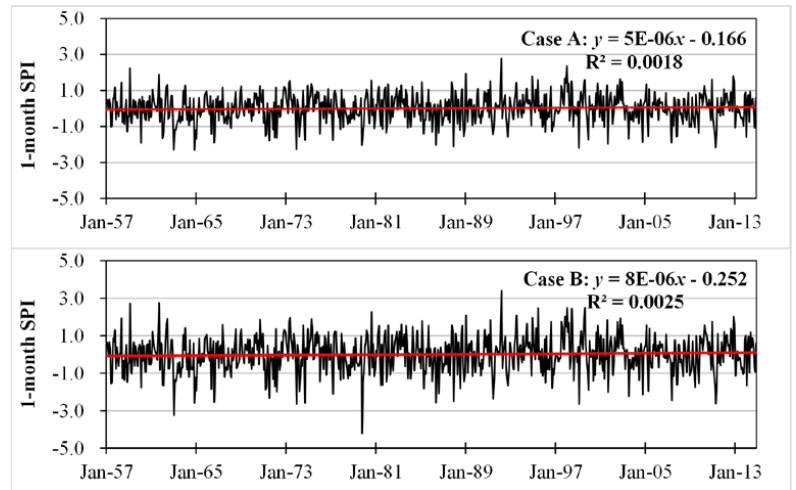
Figure 3. SPI time series obtained from the SPI-mean scheme (Case A) and from the precipitation-mean scheme (Case B), along with fitted regression lines, for the Poyang Lake Basin in 1957–2014.